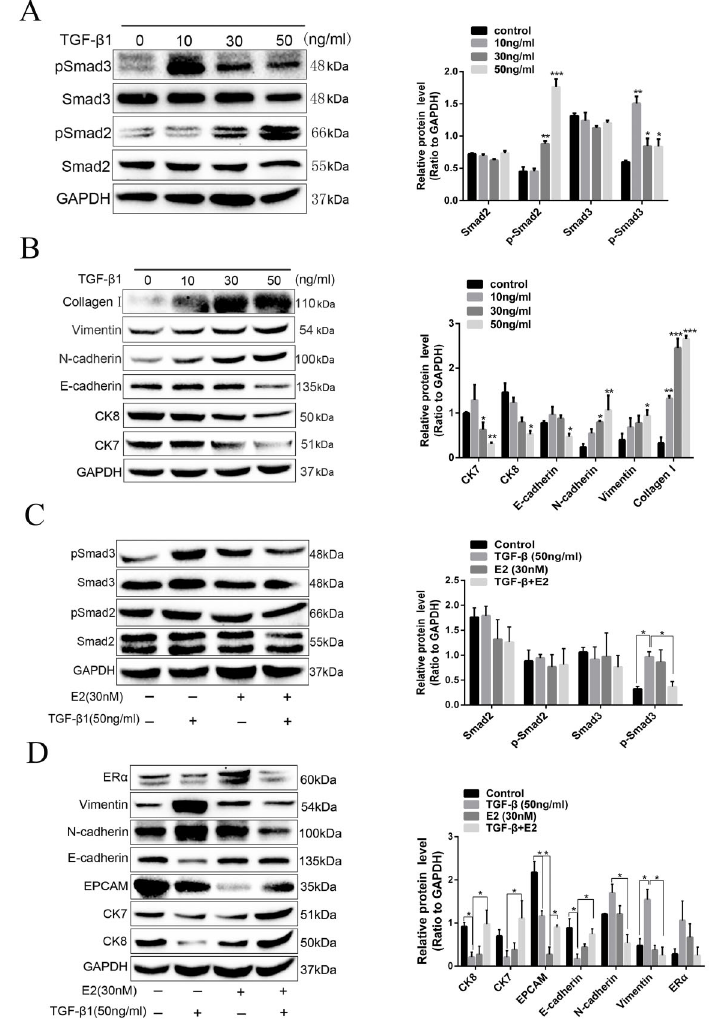
Figure 4. In fl uence of estrogen on transforming growth factor b 1 (TGF- b 1)-induced epithelial-mesenchymal transition (EMT) in intrauterine adhesion. A , Human endometrial epithelial cells were treated with TGF- b 1 for 24 h to detect the total and phosphorylation protein levels of Smad2 and Smad3 by western blotting. B , Expression of fi brotic and EMT markers was determined in cells at 24 h post- stimulation of TGF- b 1. C , The total and phosphorylation protein levels of Smad2 and Smad3 were detected in cells incubated with estrogen (E2, 30 nM) for 48 h. D , The expression of EMT markers in the TGF- b -induced cells treated with E2 was detected by western blotting. Data are reported as means ± SD. *P o 0.05, **P o 0.01, ***P o 0.001